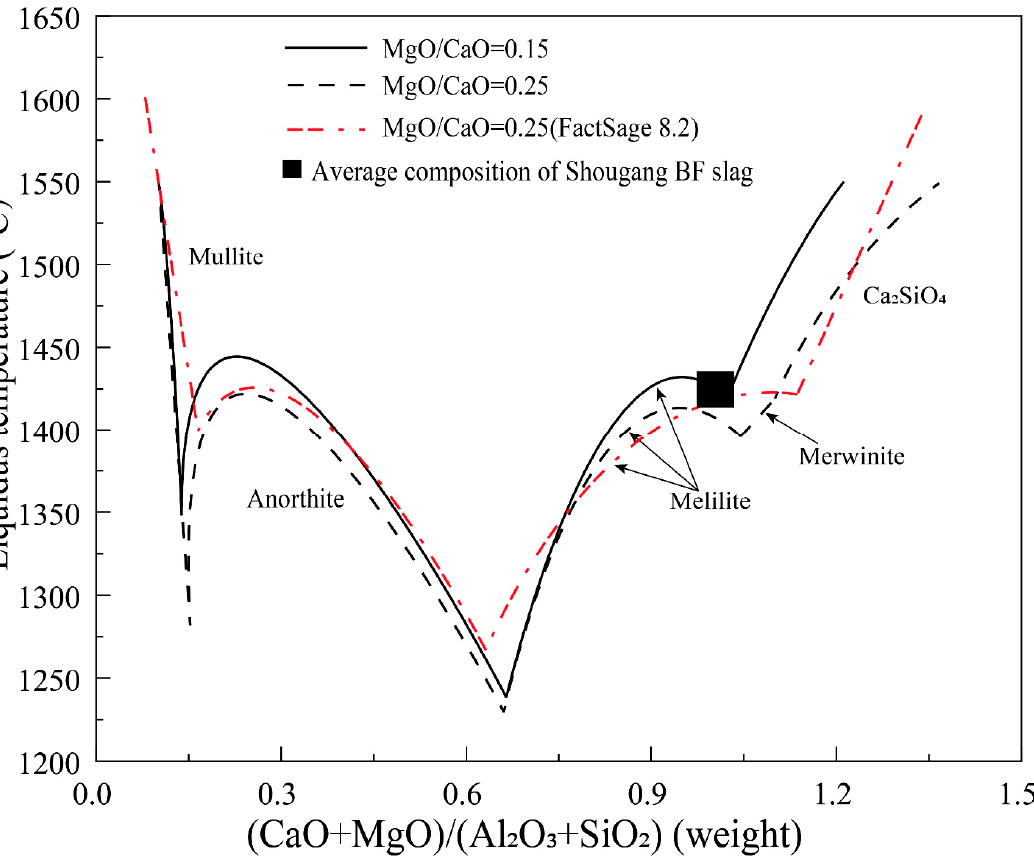
Figure 7. Liquidus temperature as a function of quaternary basicity in liquid at fixed MgO/CaO weight ratios of 0.15 and 0.25 in the CaO-MgO-SiO 2 -Al 2 O 3 system with Al 2 O 3 /SiO 2 weight ratio of 0.4.